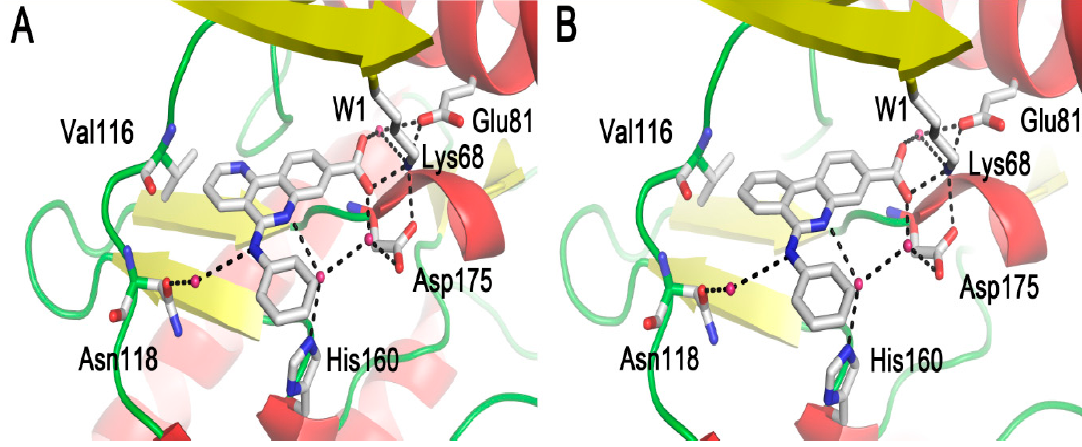
Figure 1. Binding modes of compounds ( A ) 27e and ( B ) 27h with CK2 α based on molecular docking.